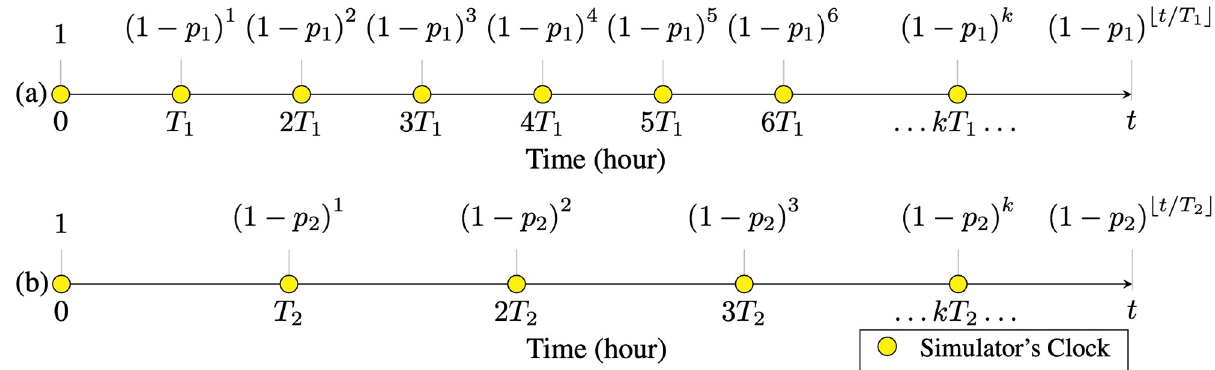
Fig 7. Simulator’s clock is translated to Virus Spread Events indicated by yellow circles on the timeline axis. In (a) and (b) two characteristically similar simulators’ timelines are displayed that only differ in their clock periods ( T 1 for (a) and T 2 for (b)). If the probability of transmission in a single clock trigger is p , the probability of disease transmission for the whole time is a geometric distribution with parameters equal to ( p , b t / T c ), where T is the clock period. The probability of disease not being transmitted is shown above the axes for a simple interaction between two individuals. In order to have consistent results for both similar simulators with different resolutions, the mentioned probabilities should be equal to each other for the simulators. In other words, (1 − p 1 ) b t / T 1 c = (1 − p 2 ) b t / T 2 c . For better illustration, in this plot the virus spread events are placed exactly at the ends of the intervals; but in simulations, they are uniformly distributed within each